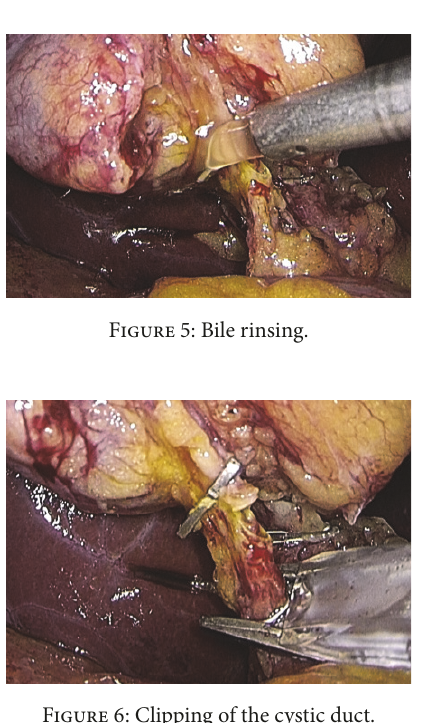
Figure 6: Clipping of the cystic duct.